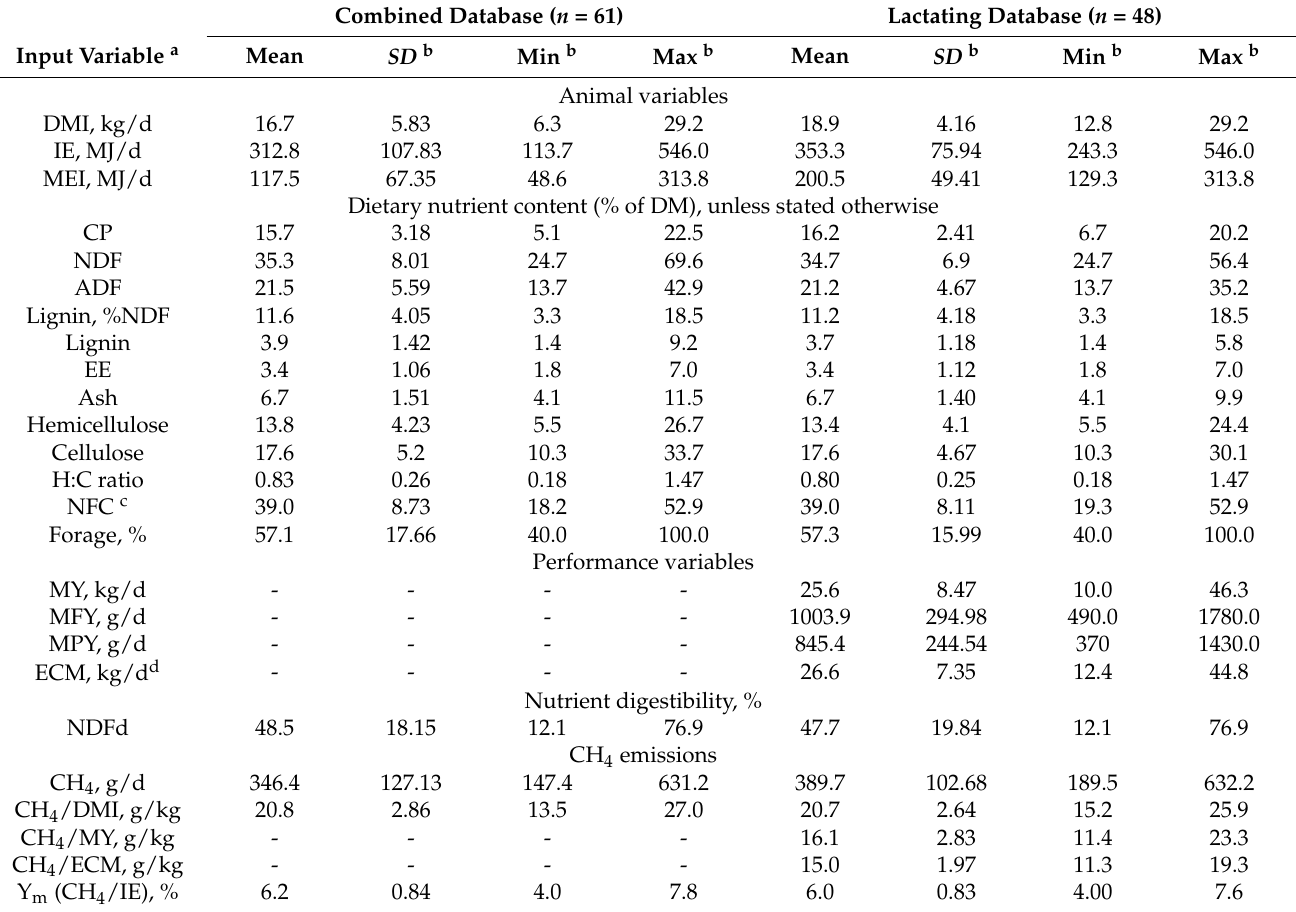
Table 2. Summary descriptive statistics of the dataset used to develop the proposed methane emission models. Combined Database ( n =